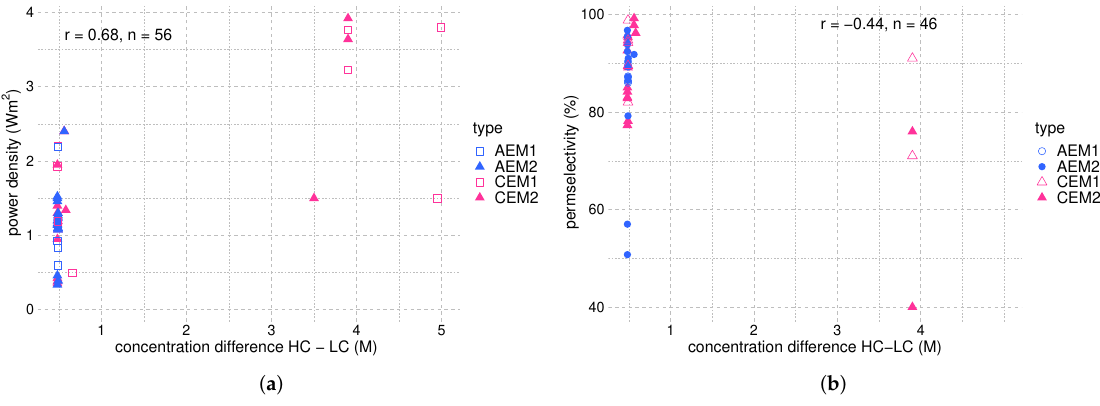
Figure 4. Power density and permselectivity plotted against the concentration gradient across the IEMs in RED studies reported in Tables 2 and 3 for NaCl. Additional data concerning commercial membranes have been collected from [92], [112] and [93]. A total of 81 observations form the basis of the analysis, with 21 observations of commercial AEMs (AEM1), 20 of tailor-made AEMs (AEM2), 23 of commercial CEMs (CEM1), and 17 of tailor-made CEMs (CEM2). The Pearson coefficient r indicates the correlation between the two plotted variables, and n refers to the number of observations used for each plot.